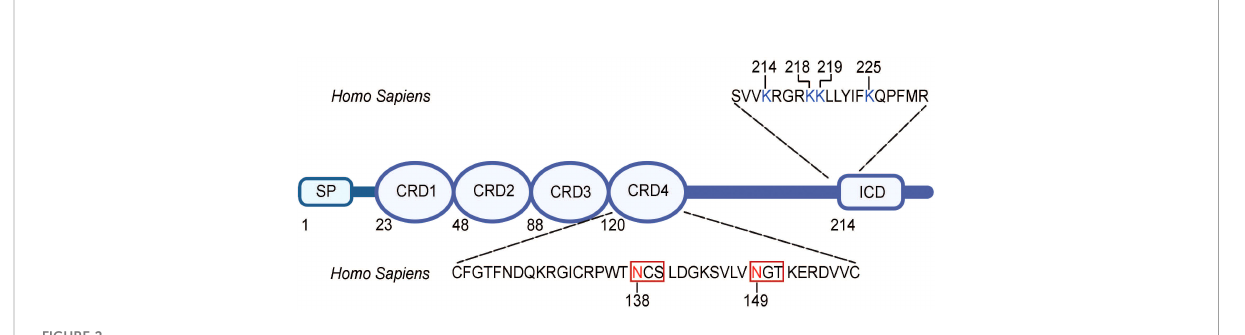
FIGURE 2 Amino acid sequence for sites of N-glycosylation and ubiquitination in human 4-1BB. N- linked glycosylation N-X-S/T motifs are found in the extracellular domain (CRD4) of 4-1BB and are boxed. Asparagine (N) residues that are glycosylated (N138, N149) is highlighted in red. The lysine resides that are ubiquitinated are found in the intracellular domain of 4-1BB and are highlighted in blue. SP, signal peptide; CRD, cysteine-rich domain; ICD, intracellular domain. The fi gure was created with